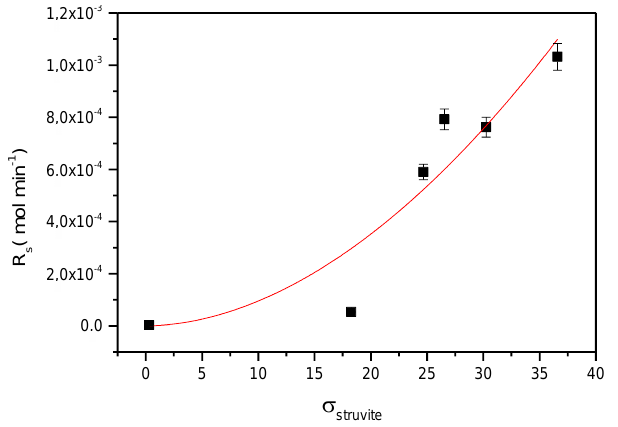
( b ) Figure 5. Precipitation of struvite from supersaturated solutions prepared according to method B (filtrate of brucite suspension); ( a ) Magnesium concentration, C Mg and ( b ) pH as a function of time; 25 ° C. Error bars are included but they are too small to show off. Magnesium concentration and pH values reached plateau values rather fast (within ca. 10 min), showing rapid precipitation of struvite at the selected supersaturation. The dependence of the rate of struvite precipitation on the initial relative supersaturation with respect to struvite is shown in the plot of Figure 6. Least squares polynomial fitting was applied to the data. The experimental conditions and the results obtained from the meas- urements during the precipitation of struvite from supersaturated solutions prepared ac- cording to method B are summarized in Table 3. The relative errors in the measurements are the same as those for Table 2. Table 3. Precipitation of struvite in its supersaturated solutions prepared according to method B.